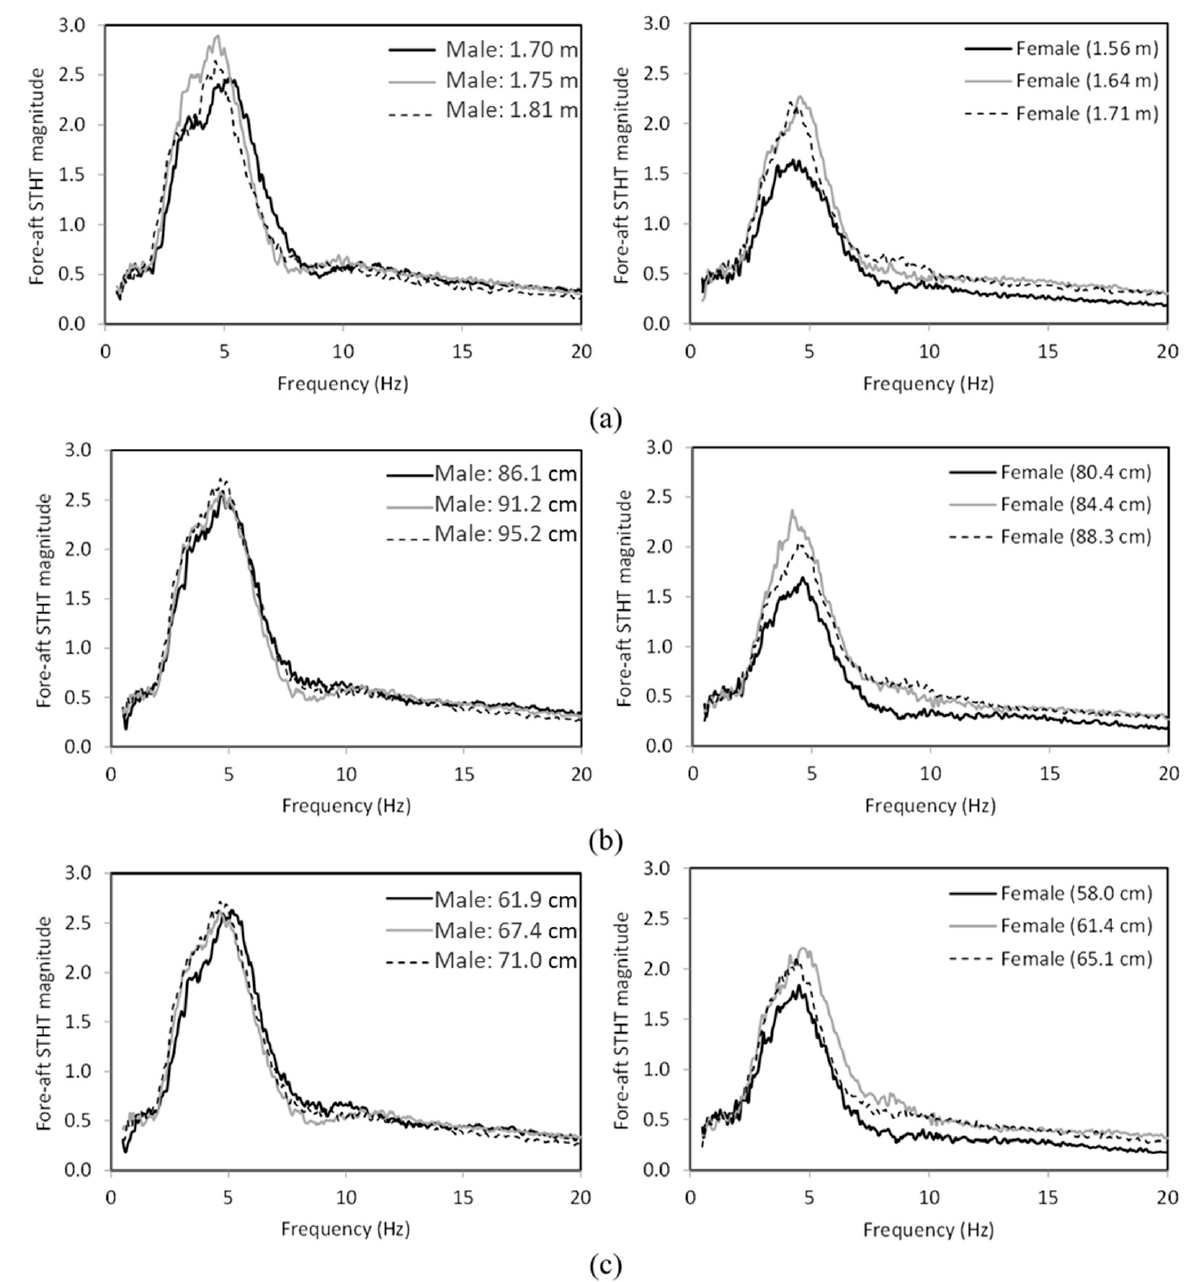
Figure 16. Effects of stature-related parameters on mean fore-aft STHT magnitude responses of male and female subjects: ( a ) stature; ( b ) sitting height; and ( c ) C7 height (NB support, 0.50 m/s 2 excitation).